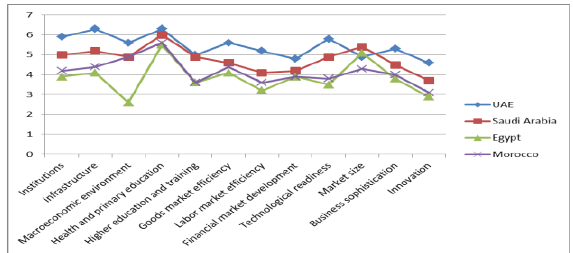
Figure 2: global competitiveness index in four